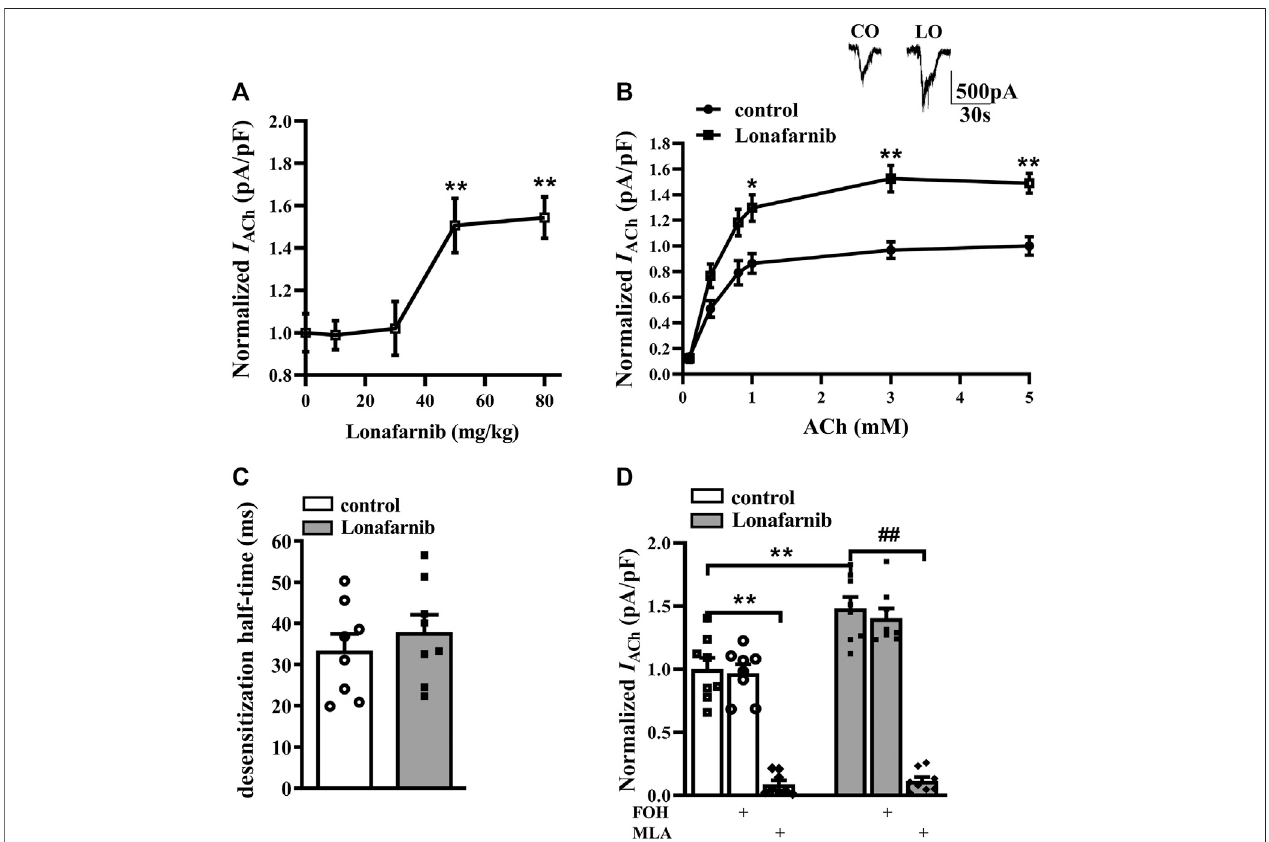
FIGURE1| Administrationoflonafarnibenhancesa7nAChRactivityinhippocampalCA1pyramidalcells. (A) Evoked I ACh byACh(3 mM)intheslicesofcontrolmice treatedwithvehicleandmicetreatedwithlonafarnibat10,30,50,and80 mg/kgfor7 days.Dose – responsecurveswereconstructedbytheamplitudeof I ACh (thevalue of current density as pA/pF) (means ± SEM) that expressed as percent of control with vehicle (100% VS control). ** P < 0.01 vs. slices of control mice (10 mg/kg: P (cid:2) 0.9999,30 mg/kg: P (cid:2) 0.9998;50 mg/kg: P (cid:2) 0.0062;80 mg/kg: P (cid:2) 0.0032, n (cid:2) 8,one-wayANOVA,followedbyDunnett ’ smultiplecomparisontest). (B) The CA1 pyramidal cells were subjected to consecutive 1 s applications of 0.1, 0.4, 0.8, 1, 3, and 5 mM ACh in control and lonafarnib-treated mice (50 mg/kg). Dose – responsecurveswereconstructed bytheamplitudeof I ACh (means ± SEM)thatwerenormalized byacontrolvalueevokedbyACh(5 mM).Representativetraces of I ACh evokedby3 mMACh.* P < 0.05,** P < 0.01vs.slicesofcontrolmice(1 mM: P (cid:2) 0.0298,3 mM: P (cid:2) 0.0043,5 mM: P (cid:2) 0.0025, n (cid:2) 8,repeated-measureANOVA, followedbySidak ’ smultiplecomparisontest). (C) In fl uenceoflonafarnibadministration(50 mg/kg)onthedesensitizationhalf-timeofa7nAChR. (D) Sensitivityofevoked I ACh to farnesol (FOH) that converts farnesyl-pyrophosphate and a7nAChR antagonist MLA. Mean percent reduction in the amplitude of I ACh evoked by ACh (3 mM) following application of MLA (10 μ M) in slices from control and lonafarnib-treated mice. Amplitude of I ACh were normalized by the value of control group with